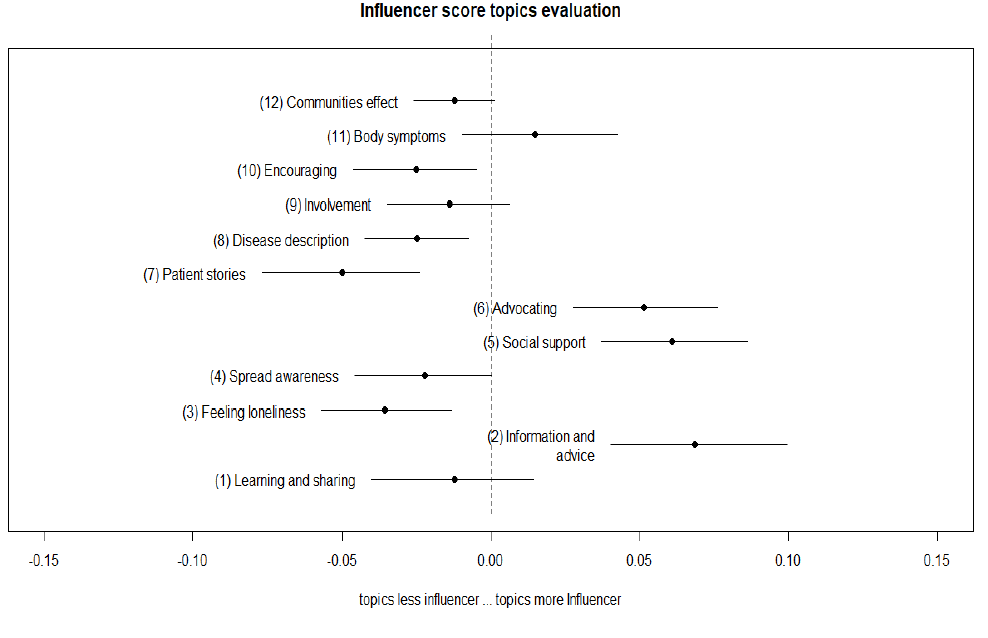
Figure 4. Estimated topic proportion to be discussed by influencer score.